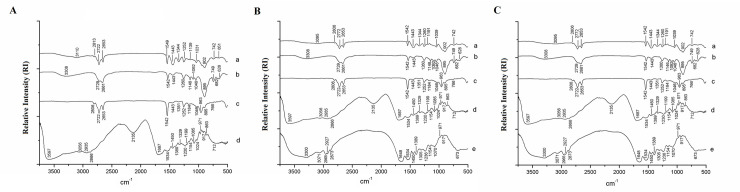
FTIR spectra of powder particles obtained by O/W emulsification technique (A) OG: Quinoa oil and porcine gelatin in aqueous phase 2 –a. OG, b. Tween 20, c. quinoa oil, d. porcine gelatin; (B) OWG1: Quinoa oil, whey protein isolate and porcine gelatin in aqueous phase 2 –a. OWG1, b. Tween 20, c. quinoa oil, d. porcine gelatin, e. whey protein isolated; (C) OWG2: Quinoa oil, whey protein isolate in aqueous phase 1, and porcine gelatin in aqueous phase 2—a. OWG2, b. Tween 20, c. quinoa oil, d. porcine gelatin, e. whey protein isolated.